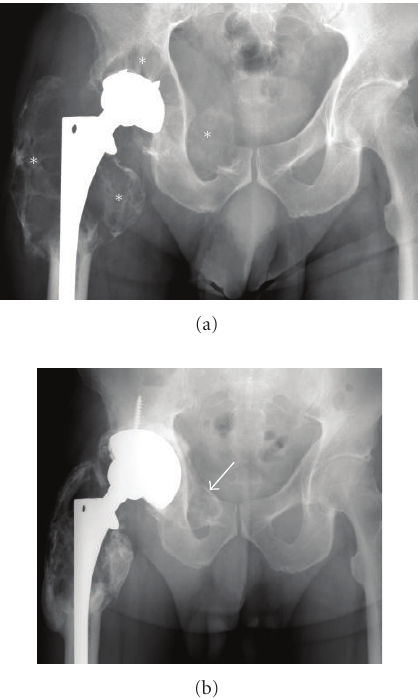
Figure 14: Particle disease. A frontal radiograph (a) illustrating large expansile lytic lesions (asterisk) mimicking tumors, diagnosed as particle disease. Note the proximity of these lesions to the prosthesis. The acetabular prosthesis was revised, and curettage and grafting using cancellous allograft (arrows) of the lytic areas was performed (b).